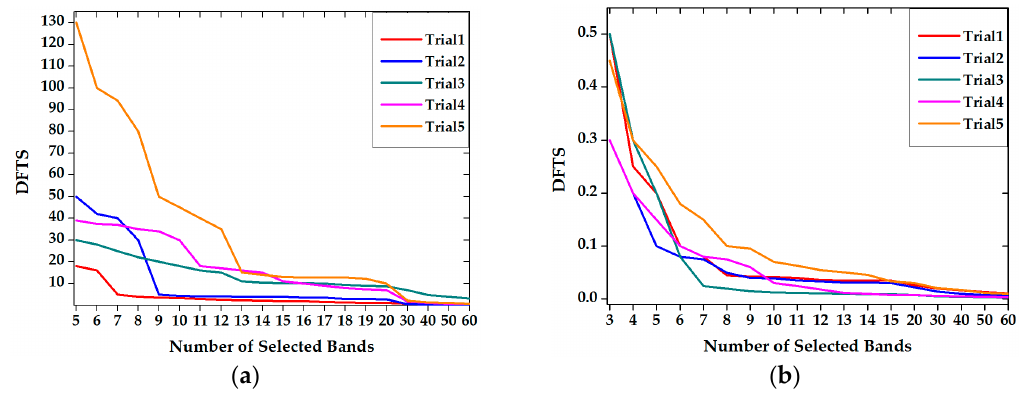
Figure 7. Number of selected bands compared to the value of parameter discriminative feature threshold scalar (DFTS) for the proposed DFM-AP in the: ( a ) Indian Pines; and ( b ) Xuzhou datasets.